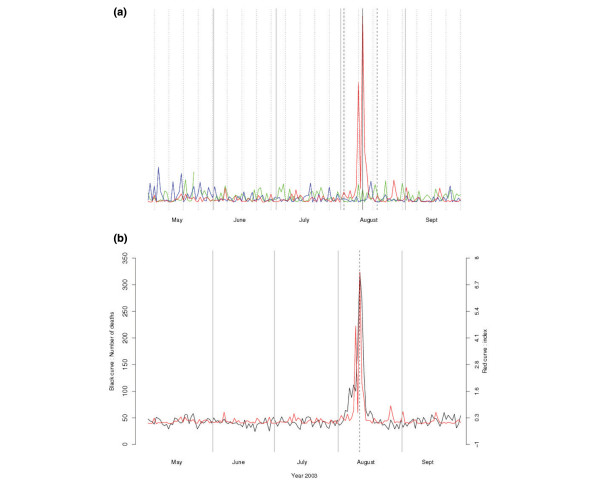
Heatstroke-related overmortality indicator: validation sample. The three annual periods were superimposed and synchronised weekly. The vertical dashed lines define the heat-wave period (3–19 August 2003). (a) Indicator calculated for validation using the Hôtel-Dieu Hospital data (2001, blue curve; 2002, green curve; 2003, red curve). (b) Hôtel-Dieu indicator (red curve) and Paris mortality (black curve).